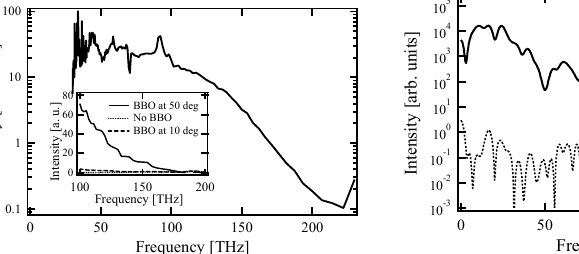
Fig. 1 Spectrum of the infrared pulse observed using monochromator and MCT detector.Inset shows the dependence on the BBO crystal conditions.